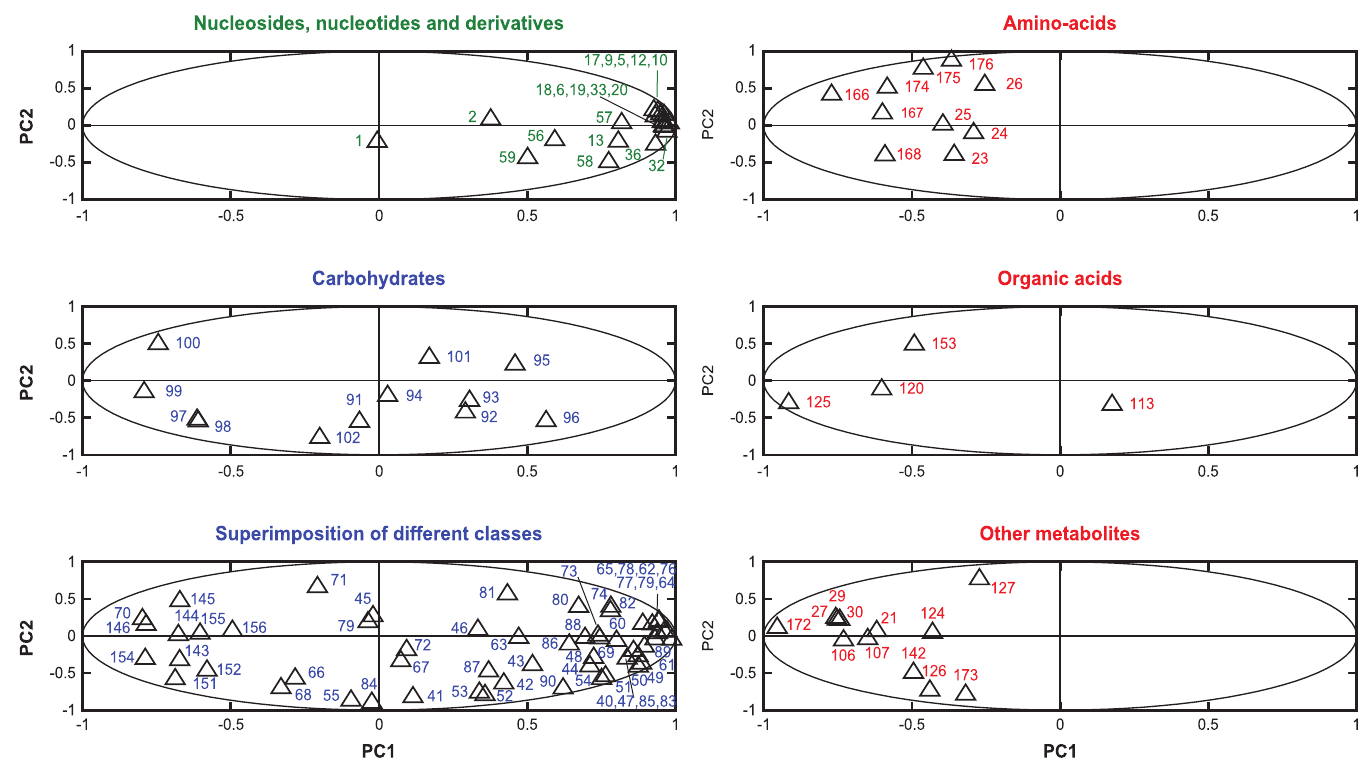
Fig 4. Loading plots from the PCA of replicates of E . coli nano-TiO 2 stressedaccording to the type of nano-TiO 2 and to the conditions of illumination with 100 ppm of nano-TiO 2 . Only assignedareas are shown (see S2 Table), and split on graphsfor a better readability.